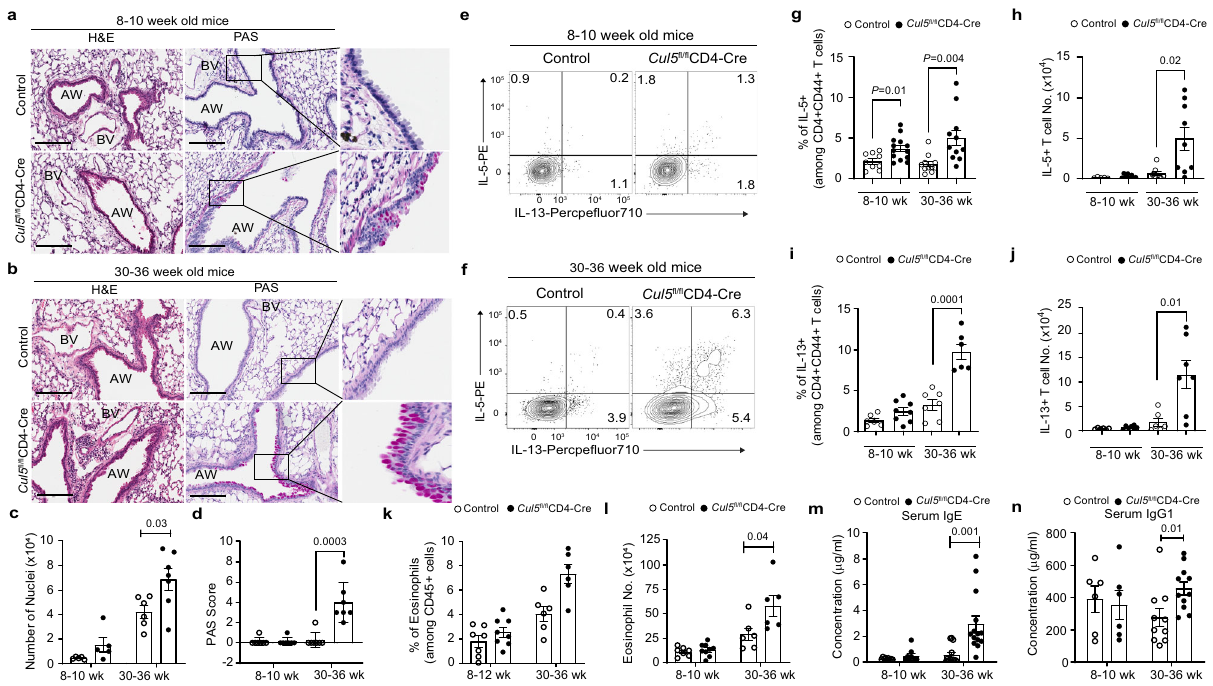
Fig. 2 Cul5 fl / fl CD4-Cre mice develop an unprovoked Th2-mediated lung in fl ammation. 8 – 10 or 30 – 36 week old control and Cul5 fl / fl CD4-Cre mice were analyzed. Hematoxylin and Eosin (H&E) and Periodic Acid Schiff (PAS) stain of lung sections. Representative image of stains of lung sections from 8 – 10-week- old ( a ) and 30 – 36 week old ( b ) mice. Bar graph showing the number of nuclei ( c ) enumerated by Aperio ImageScope software in 100 mm 2 area of lungs. PAS score ( d ) of the lung sections. For a and c , n = 5 for 8 – 10 week old control and Cul5 fl / fl CD4-Cre mice; for 30 – 36 week old n = 6 control; 7 Cul5 fl / fl CD4-Cre mice. For b and d n = 7 control and Cul5 fl / fl CD4-Cre mice examined over two independent experiments; Scale bars, 200 μ M, zoomed image of PAS is shown in right. e , f Representative fl owplotsshowingthepercentages ofIL-5 + andIL-13 + cellsamongCD44 + CD4 + Tcellsfromlung. g Compileddatashowingthefrequenciesof IL5 + cells in 8 – 10 week old mice n = 9 control; n = 13 Cul5 fl / fl CD4- Cre examined over four independent experiments, and 30 – 36 week old mice n = 10 control; n = 11 Cul5 fl / fl CD4-Cre examined in 3 independent experiments. h Numbers of IL-5 + cells in 8 – 10-week old mice n = 5 control; n = 8 Cul5 fl / fl CD4- Cre, examined in three independent experiments, and 30 – 36-week-old mice, n = 8 control; n = 9 Cul5 fl / fl CD4-Cre , examined in two independent experiments. i Frequencies and j number of IL-13 + cells in lungs. For 8 – 10 week old mice n = 6 control, n = 8 Cul5 fl / fl CD4-Cre , examined in 3 independent experiments; for 30 – 36 week old mice n = 7 control, n = 6 Cul5 fl / fl CD4-Cre , examined in two independent experiments. k Frequencies of eosinophils in thelungs. For 8 – 10- week old mice, n = 7control, 8 Cul5 fl / fl CD4-Cre examined in three independent experiments, and for 30 – 36-week-old, n = 6 mice examined in two independent experiments. k Number of eosinophils in the lungs of 8 – 10- week old mice, n = 7 control, n = 9 Cul5 fl / fl CD4-Cre , examined in three independent experiments, and for 30 – 36-week-old, n = 6 control and Cul5 fl / fl CD4-Cre mice examined in two independent experiments. m Serum IgE levels. For 8 – 10 week old mice, n = 9 control and Cul5 fl / fl CD4-Cre mice examined in three independent experiments, and for 30 – 36-week-old mice, n = 13 control, n = 14 Cul5 fl / fl CD4-Cre , examined over 4 independent experiments. Serum IgG1 levels. For 8 – 10 week old, n = 12 control and Cul5 fl / fl CD4-Cre mice examined in three independent experiments, and for 30 – 36-week-old mice, n = 10 control, n = 11 Cul5 fl / fl CD4-Cre , examined over three independent experiments. Data is presented as Mean±SEM in panels c , d , g – n . p- value is calculated by unpaired two-tailed t- test. AW Airways; BV-blood vessel. Source data are provided as a Source Data fi